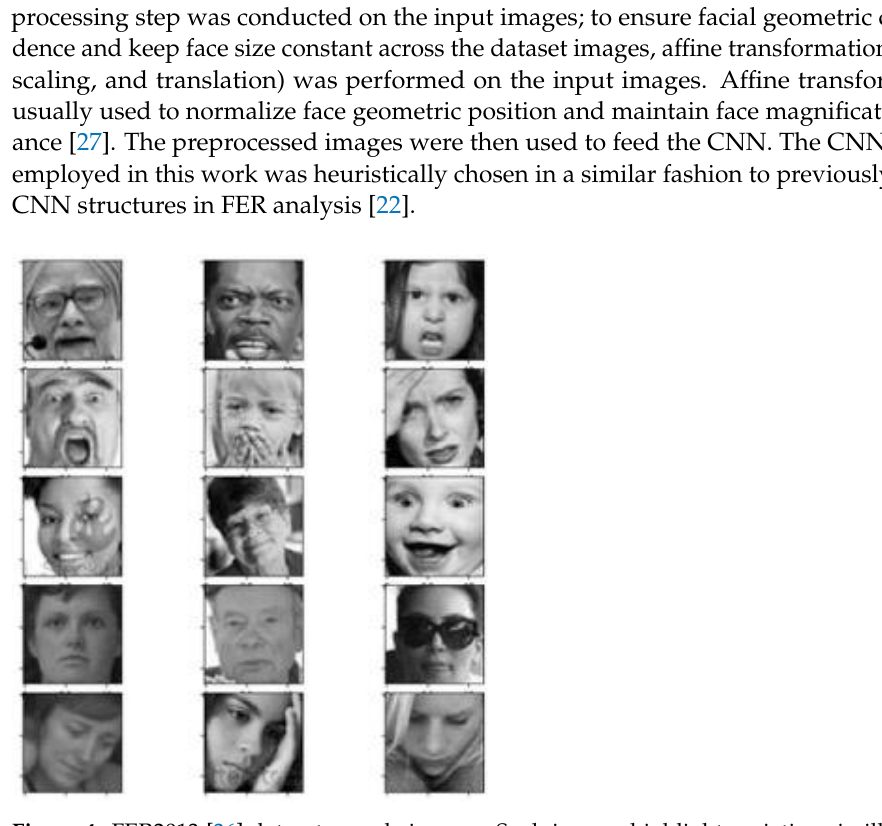
Figure 4. FER2013 [26] dataset sample images. Such images highlight variations in illumination, pose, expression intensity, age, and occlusions typical of the dataset.